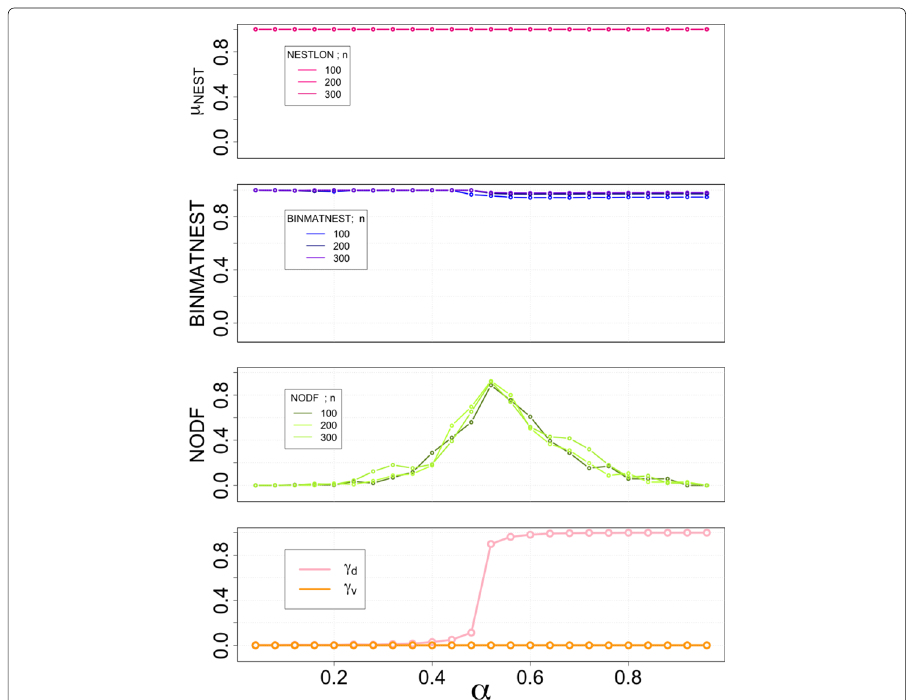
Fig. 3 Robustness analysis for detecting the nested component among BINMATNEST, NODF and NESTLON on a benchmark graph. By definition all realisations of the benchmark graph are nested for all values of α . We perform the computation on a graph of size n = 100,200,300. The graph density (i.e. γ d ) increases with α , whereas the density of violations (i.e. γ v ) remains around